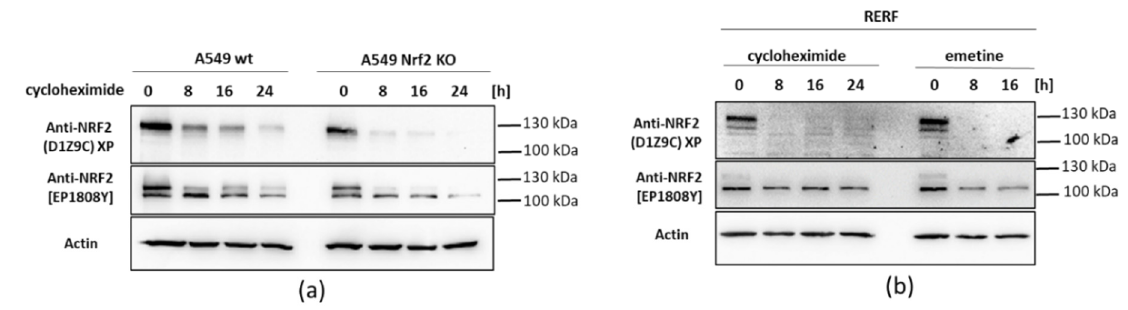
Figure 3. Nrf2 after translation inhibition. ( a ) Western blot analysis of A549 wt and A549 Nrf2 KO cells after treatment with translation inhibitors cycloheximide (chx) at different time points (8, 16, and 24 h). Nrf2 was detected using Cell Signaling (D1Z9C) and Abcam [EP1808Y] antibodies. ( b ) Western blot analysis of RERF cells after treatment with translation inhibitors cycloheximide (chx) and emetine at different time points (8, 16, and 24 h). Nrf2 was detected using Cell Signaling (D1Z9C) and Abcam [EP1808Y] antibodies.